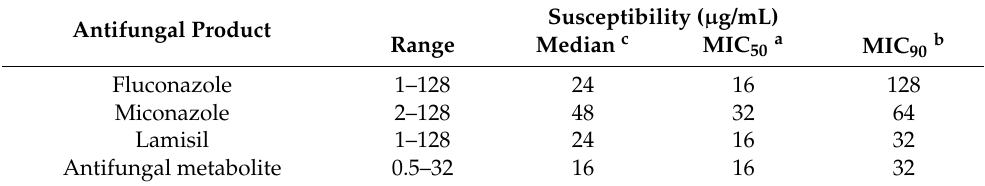
Table 3. In vitro susceptibilities of six C. albicans isolates to fluconazole, miconazole, Lamisil, and the antifungal metabolite determined by broth microdilution.